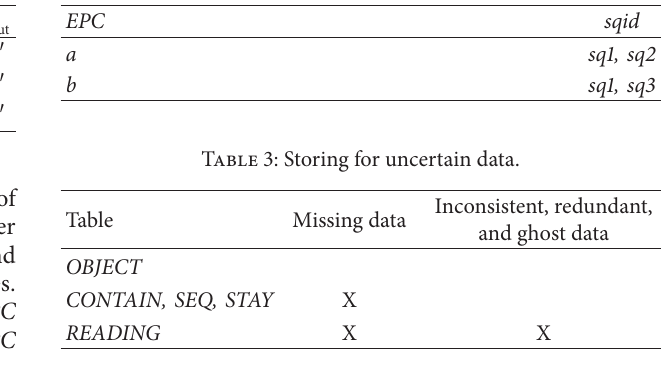
Table 1: Sample SEQ . Table 2: Sample STAY .